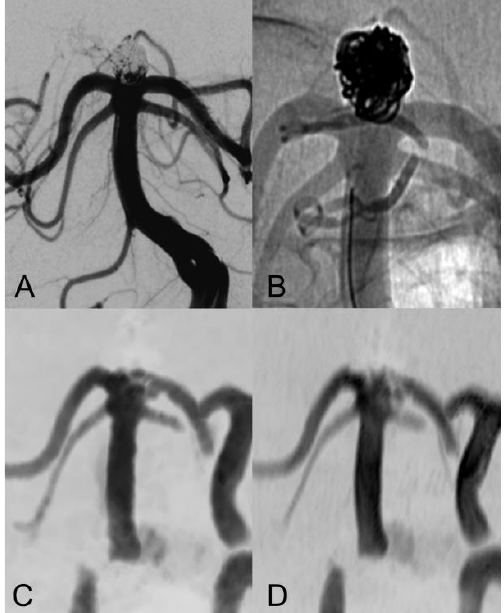
Figure 1. Anteroposterior view of vertebral artery digital subtraction angiography (DS) with ( A ) and without subtraction ( B ) after basilar-tip aneurysm coiling. Coronal MIP images of CS TOF ( C ) and PI TOF ( D ) showing complete occlusion of the aneurysm (class I). The interface between blood flow and coils is sharper on CS TOF images compared to PI TOF.